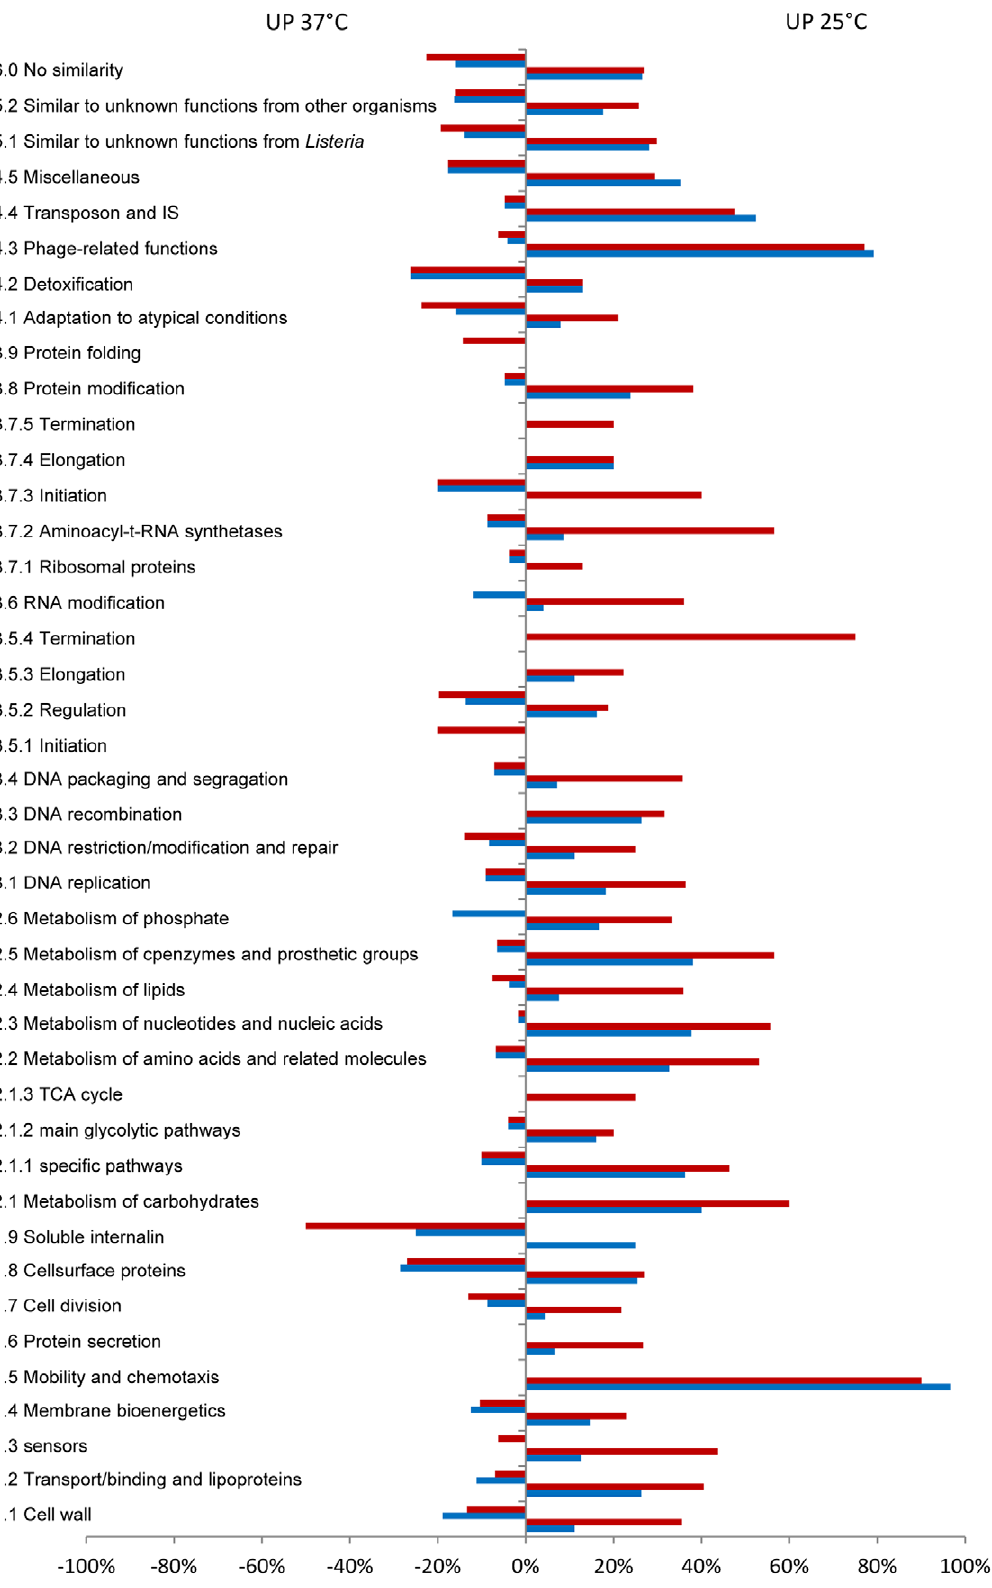
Figure 2. Percentage of genes varying significantly according to the temperature and distributed within functional categories. (red boxes) L. monocytogenes EGD-e; (blue boxes) L. monocytogenes DG125A.